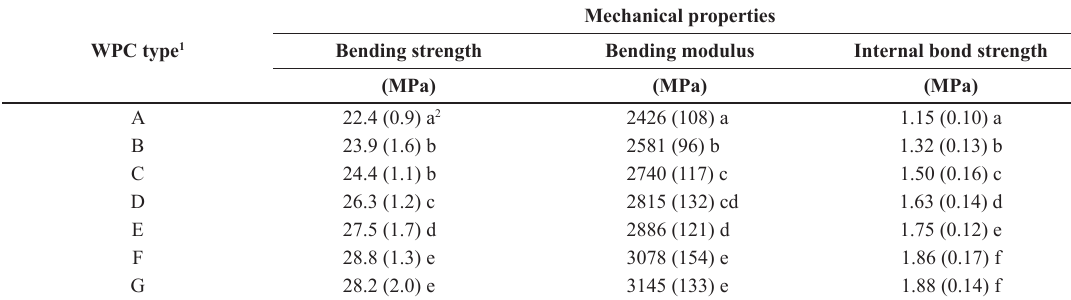
Table 3. Mechanical properties of WPC panels with and without charcoal